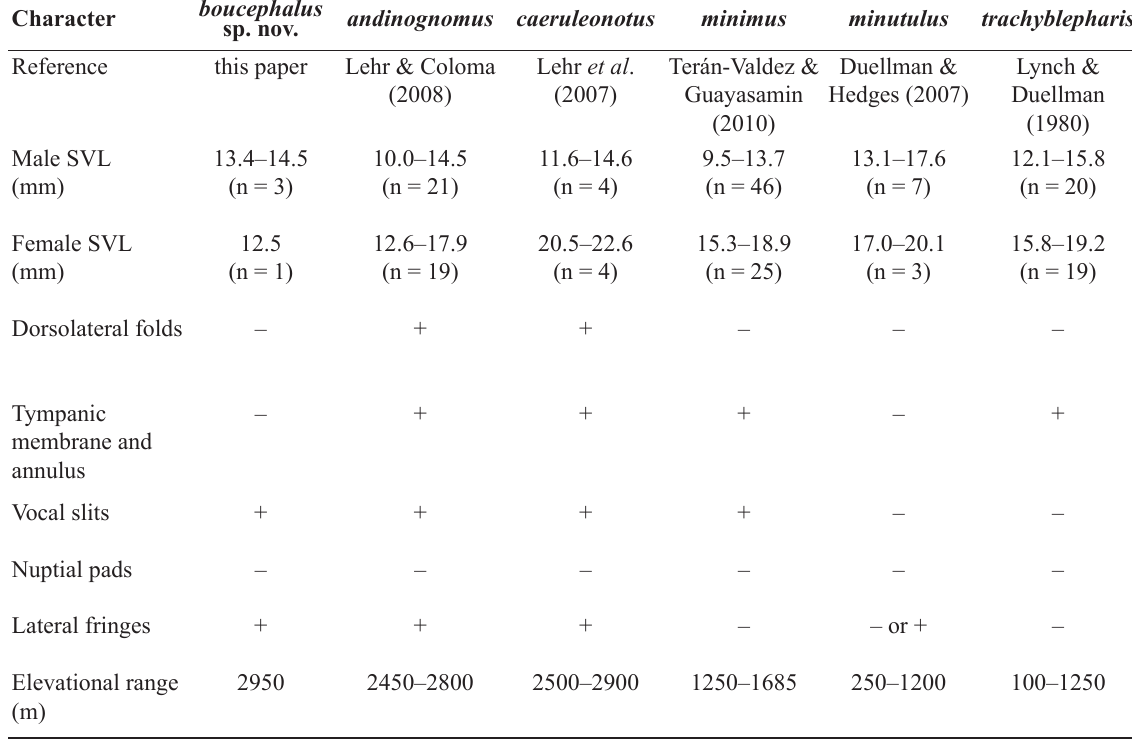
Table 2. Comparisons of P. boucephalus sp. nov. with other small and minute species of Pristimantis from Ecuador and Peru. Characters were taken from original species descriptions and the examined material. Presence of a character is indicated by ‘+’, its absence by